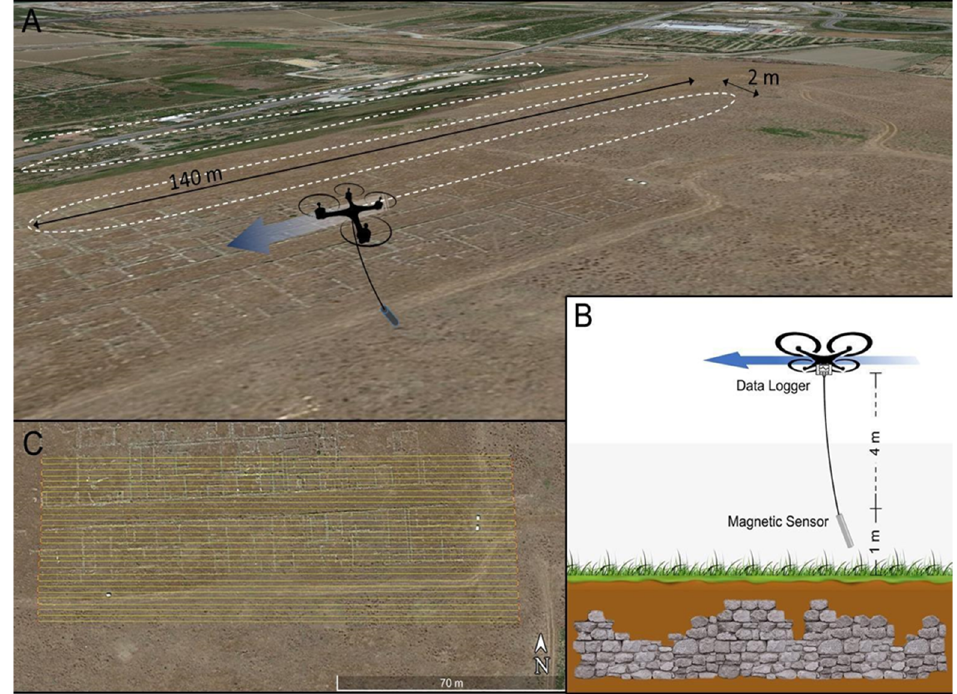
Figure 3. ( A ) UAV flight plan over the test site. ( B ) Scheme of the acquisition of the UAV-magnetometer platform. ( C ) The path of the performed mission follows E-W oriented tracks spaced 2 m.